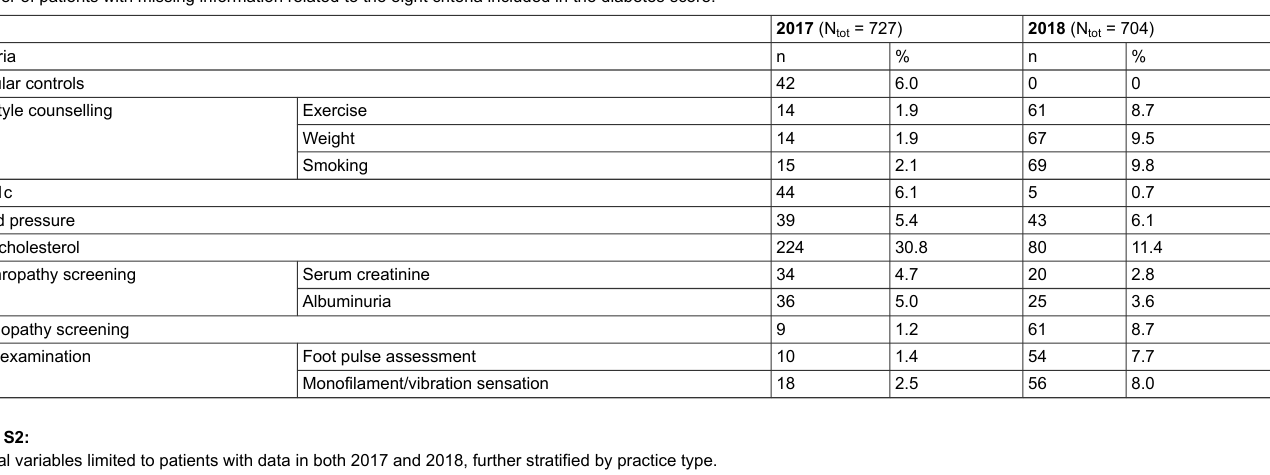
Table S1: Number of patients with missing information related to the eight criteria included in the diabetes score.